Question: Condense the content of this figure into a single sentence.
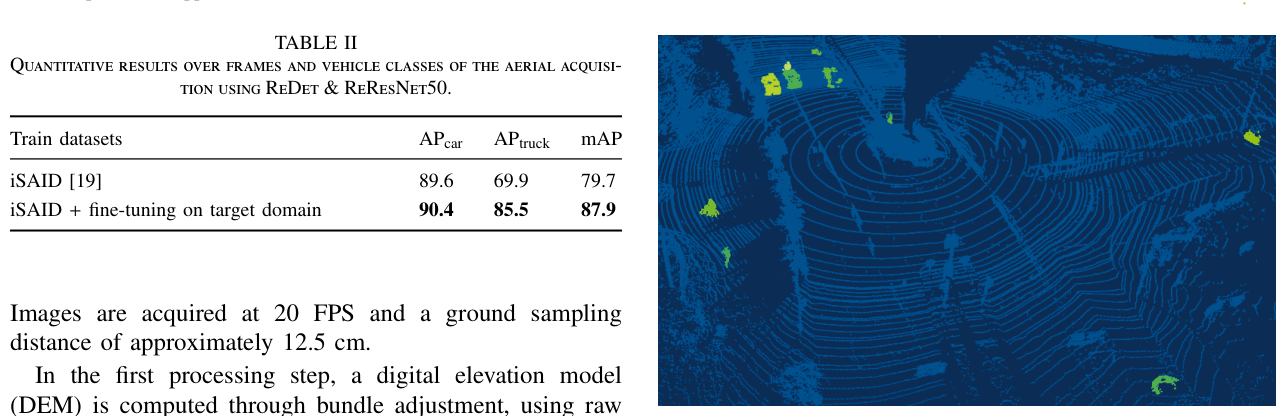
Answer: A point cloud from the infrastructure recording after applying the processing pipeline. Background points are colored in blue and points belonging to an object have a different color based on the tracked object.